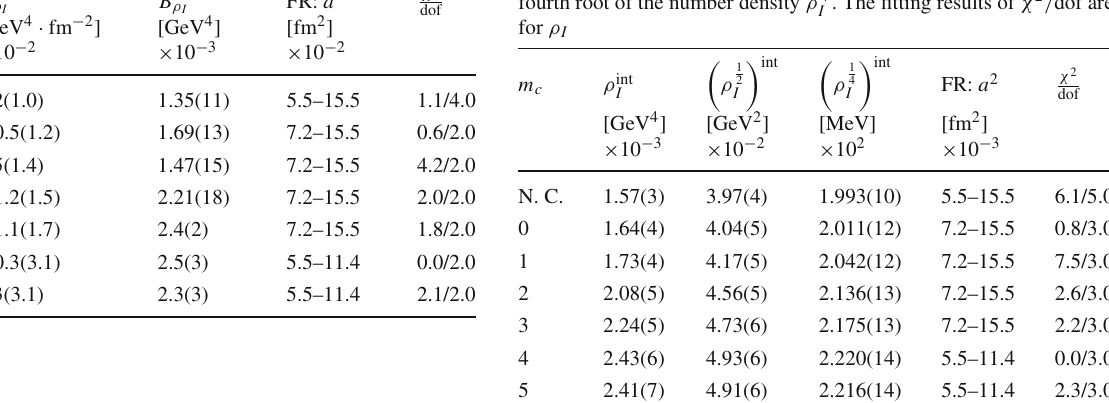
Table 6 The fitting results of the number density ρ I of the instantons and anti-instantons by interpolation